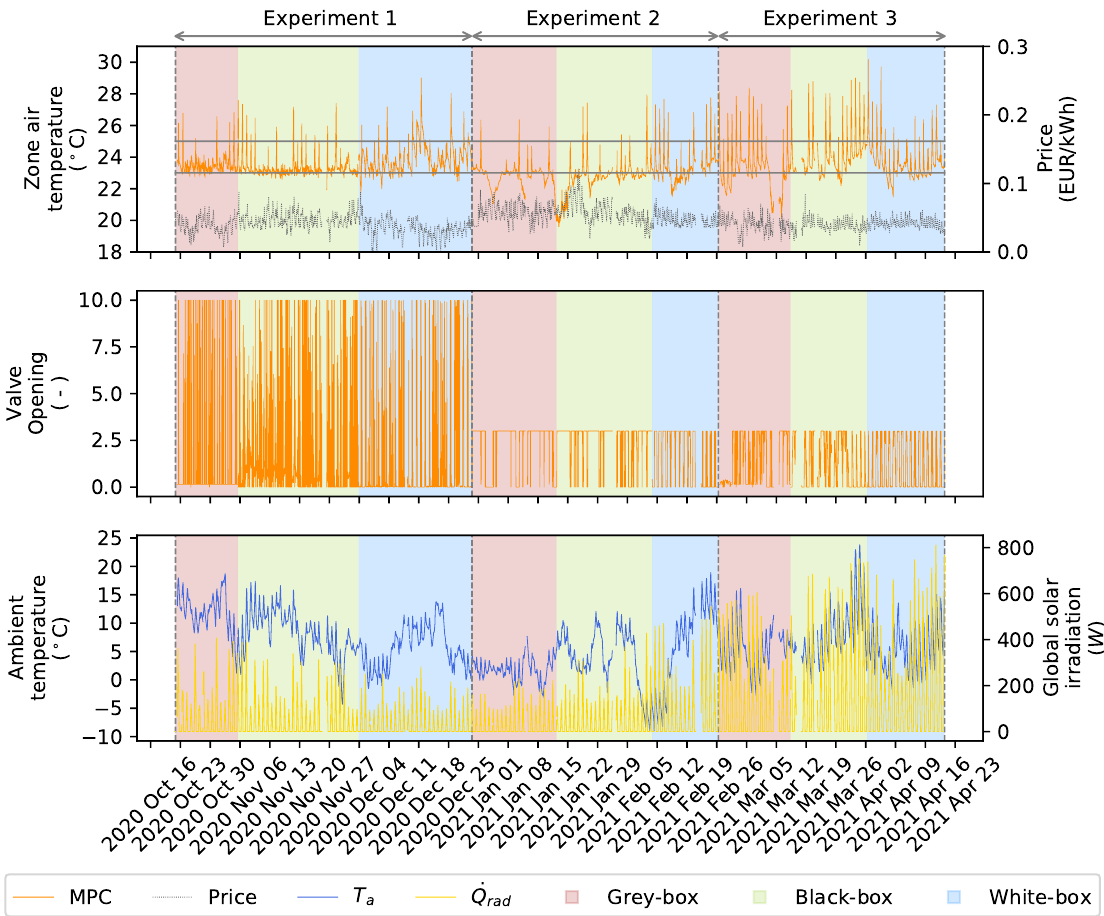
Figure 4. Experimental results with MPC applied in the real test